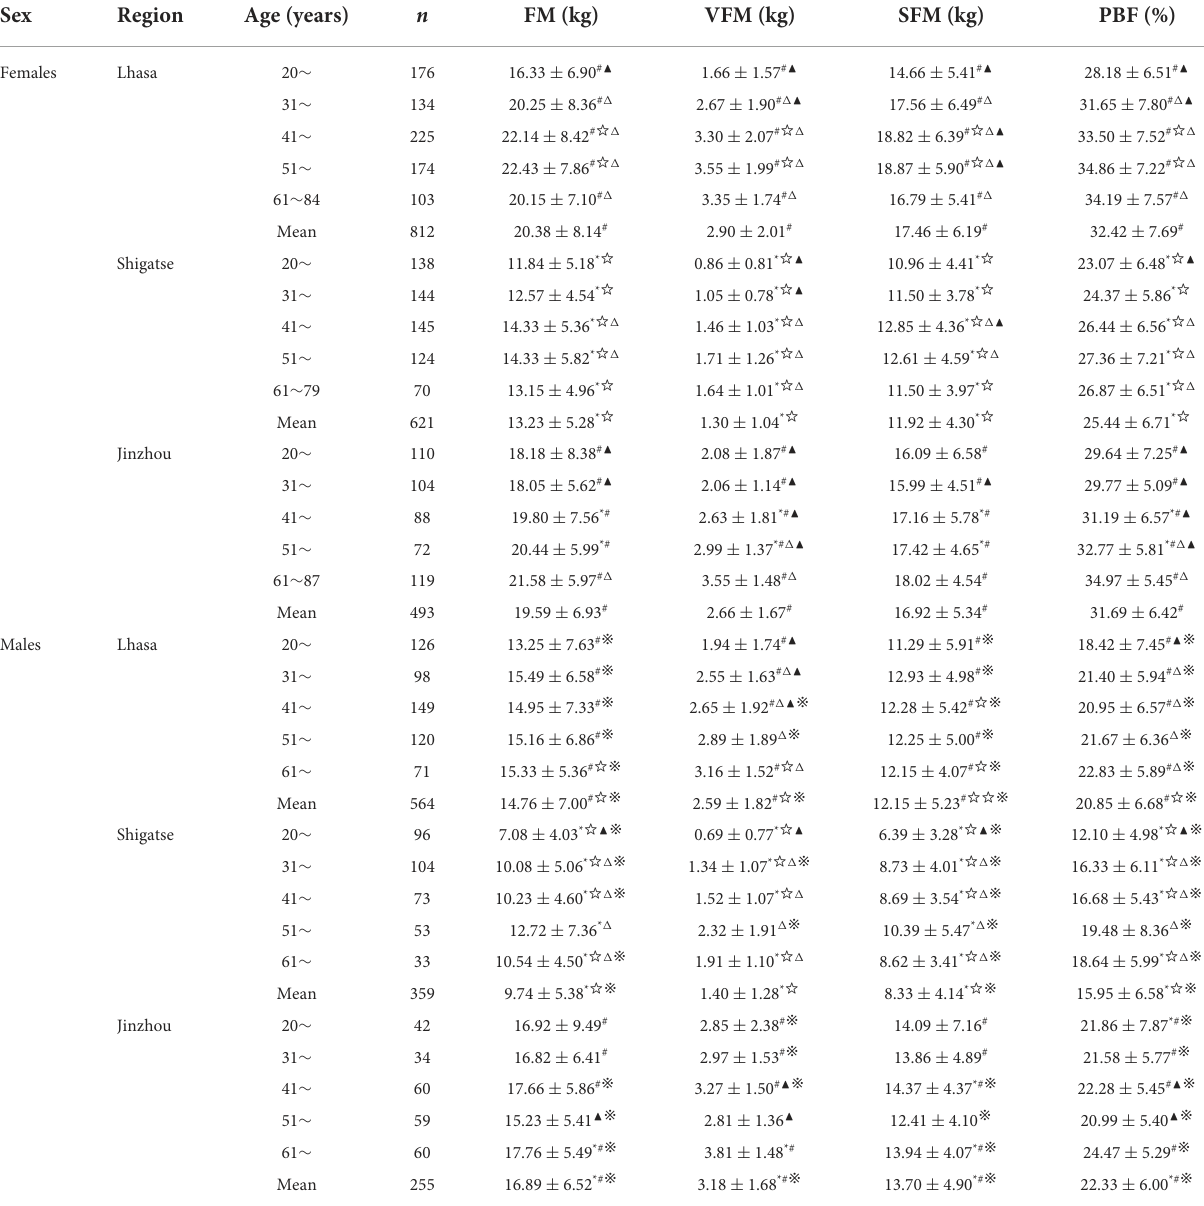
TABLE 3 Sex-specific body composition of fat mass as stratified by age and altitude. Sex Region Females